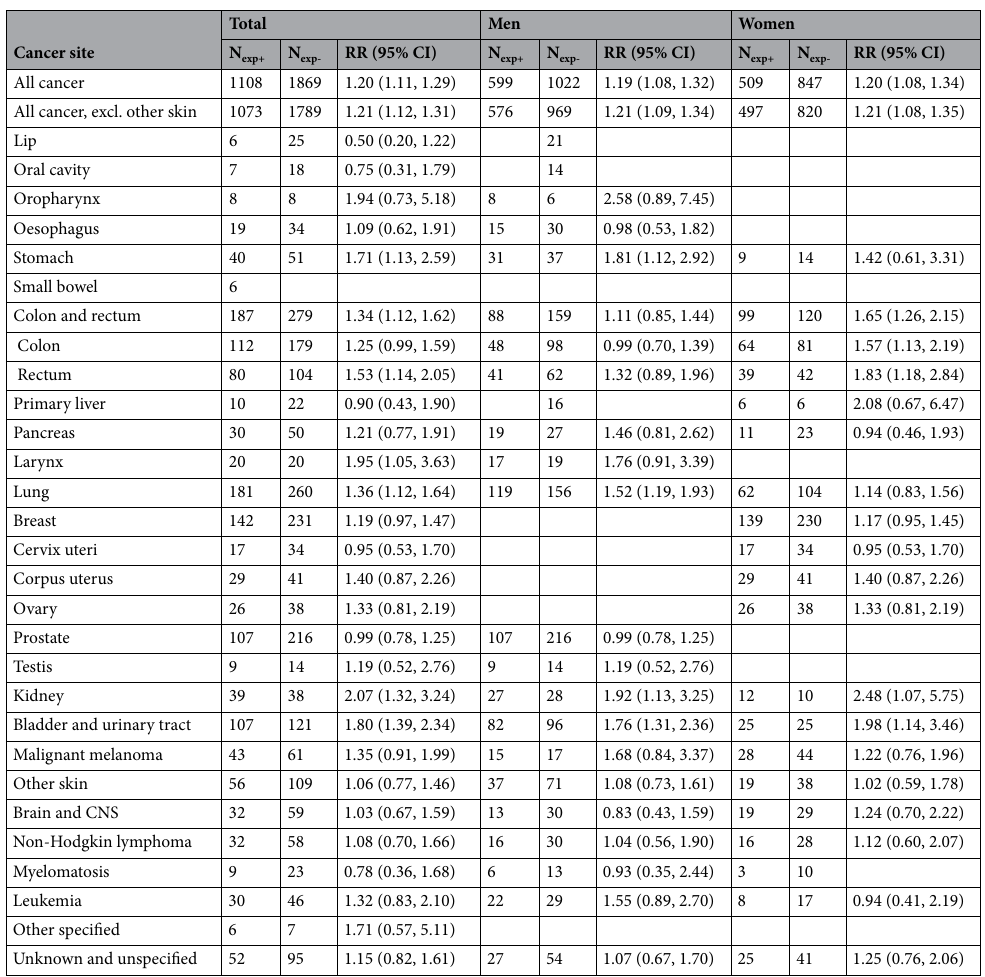
Table 2. Cancer incidence in Thyborøn-Harboøre in 1968–1970 compared with cancer incidence in geographical control group. Number of cancer cases in Thyborøn-Harboøre (N exp+ ), number of cancer cases in Holmsland-Hanstholm (N exp- ).rate ratio (RR), and 95% confidence interval (CI). RR adjusted for running age in 5-years age group, 5-year calendar period of follow-up time, and for total also for sex. Blank cell means cancer site not relevant in that sex, or less than 5 observed